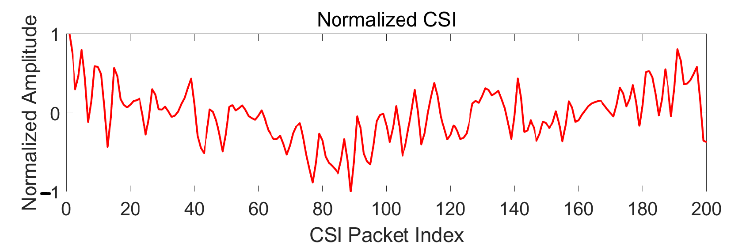
Figure 13. Normalization of CSI after de-noising.